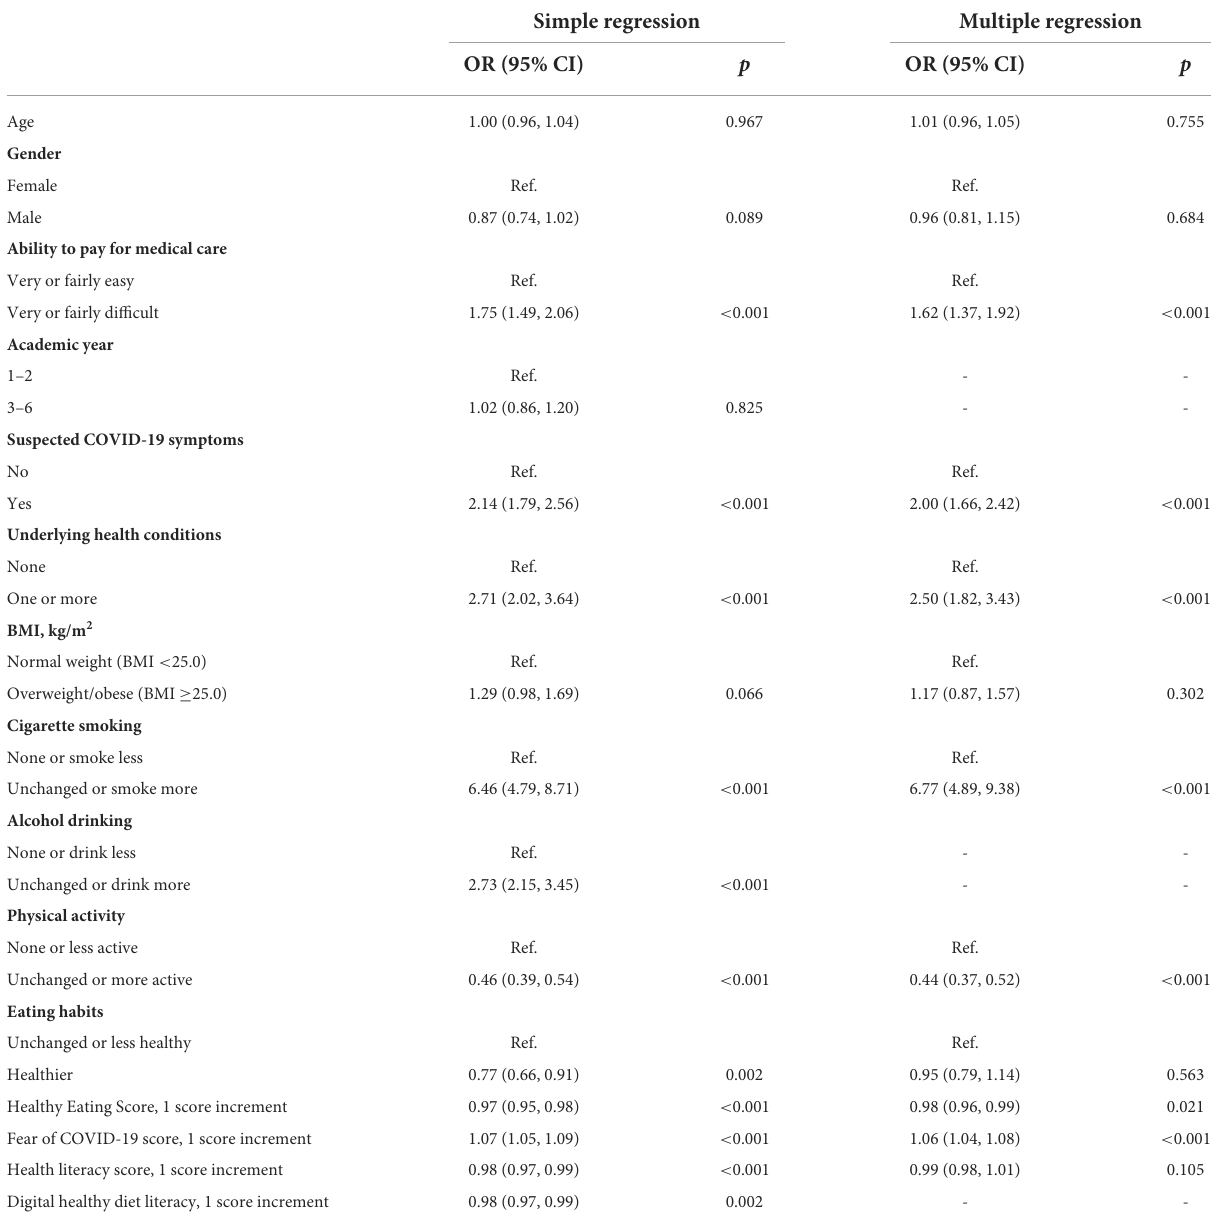
TABLE 3 Factors associated with depression among medical students ( n =